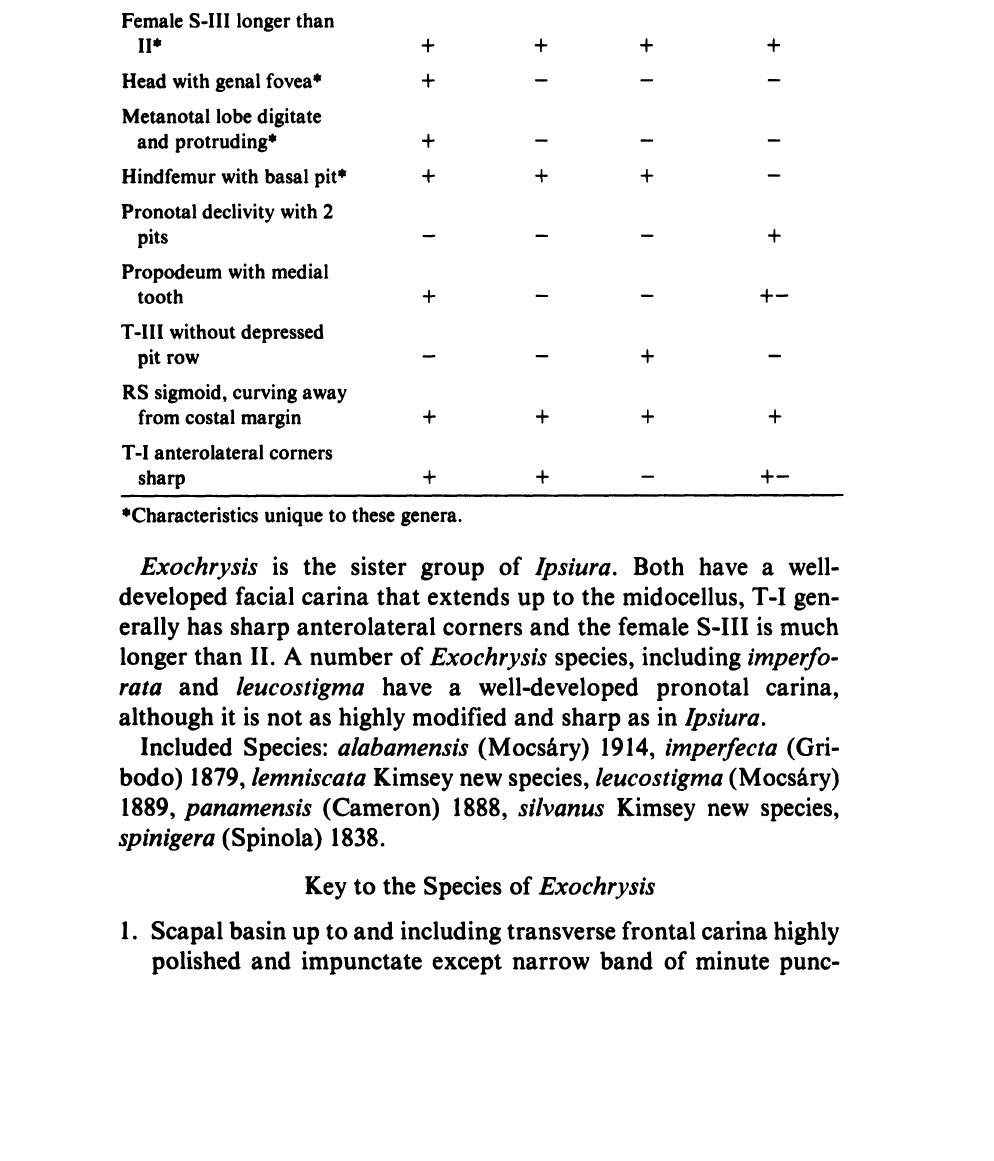
Table I. Generic Characteristics of Exochrysis, Ipsiura, Neochrysis and Pleuro- chrysis. Characteristic Exochrysis